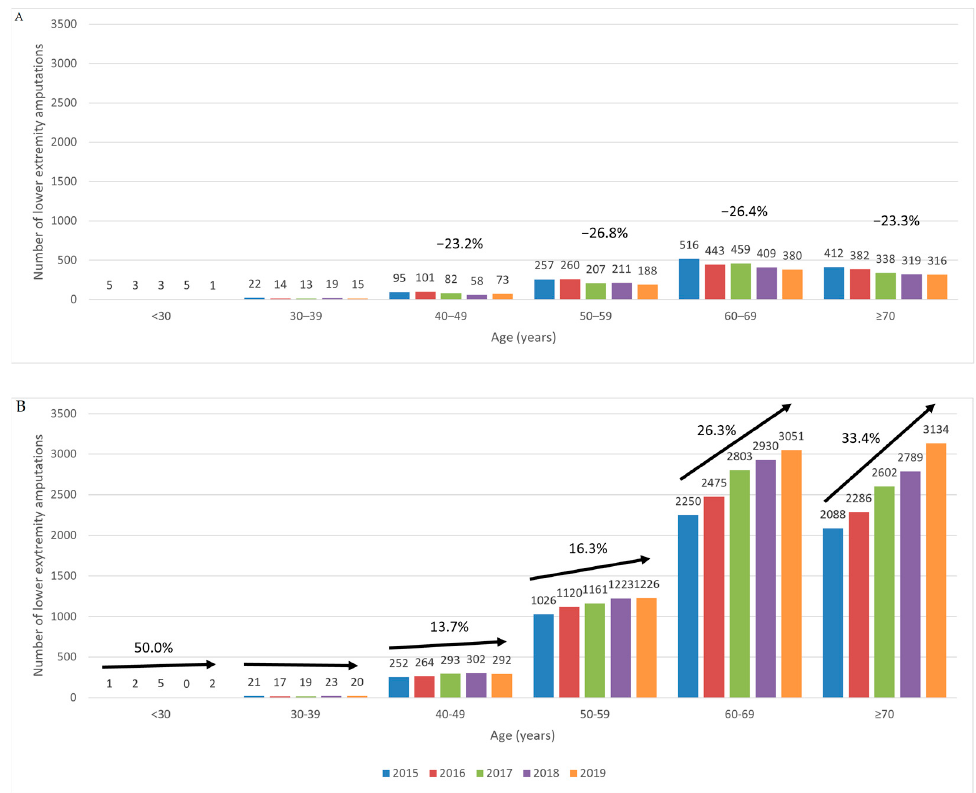
Figure 5. Trends in the numbers of lower extremity amputations in patients with T1DM ( A ) and T2DM ( B ) diabetes, according to age. T1DM, type 1 diabetes mellitus; T2DM, type 2 diabetes mellitus.